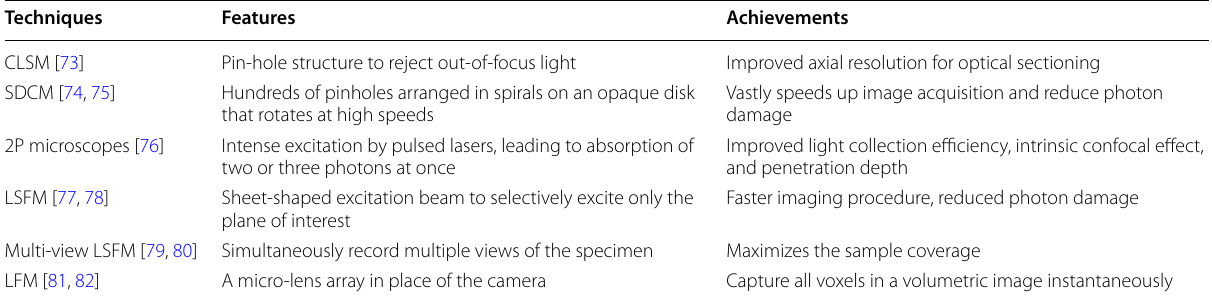
CLSM confocal laser scanning microscope, SDCM spinning disk confocal microscopy, 2P two-photon, LSFM light-sheet fluorescence microscopy, LFM light-field microscopy